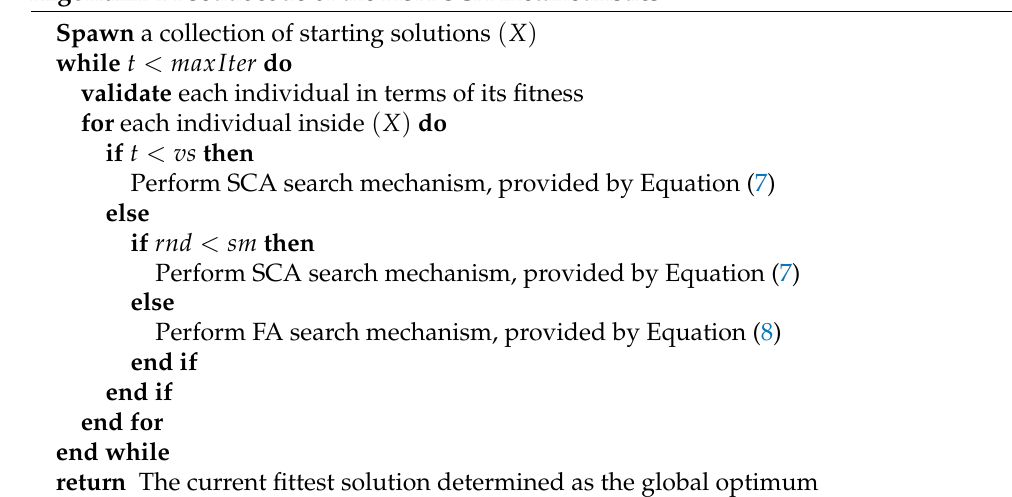
Algorithm 1 Pseudocode of the HSA-SCA metaheuristics